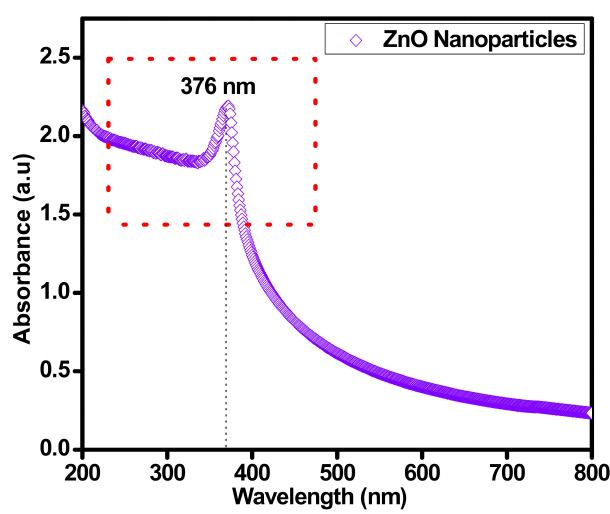
Figure 4. Confirmation of sonochemically synthesized ZnO by UV–VIS